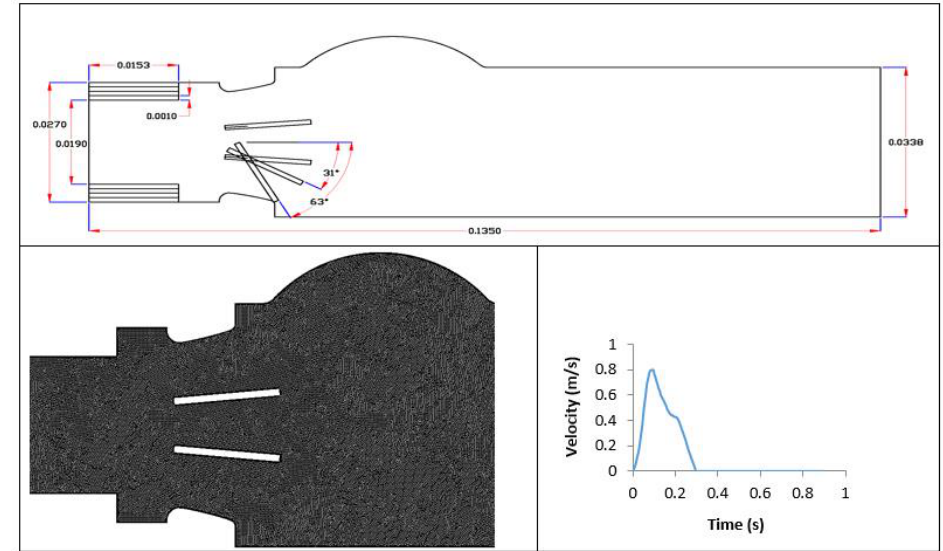
Figure 1. Model geometry with dimensions (m) for 15 different cases: 0% dysfunction (LVOT diameter: 27, 25, 23, 21 and 19 mm); 50% dysfunction (LVOT diameter: 27, 25, 23, 21 and 19 mm) and 100% dysfunction (LVOT diameter: 27, 25, 23, 21 and 19 mm). Mesh quality and velocity file for the healthy model at normal cardiac output (5 L/min) are also shown.